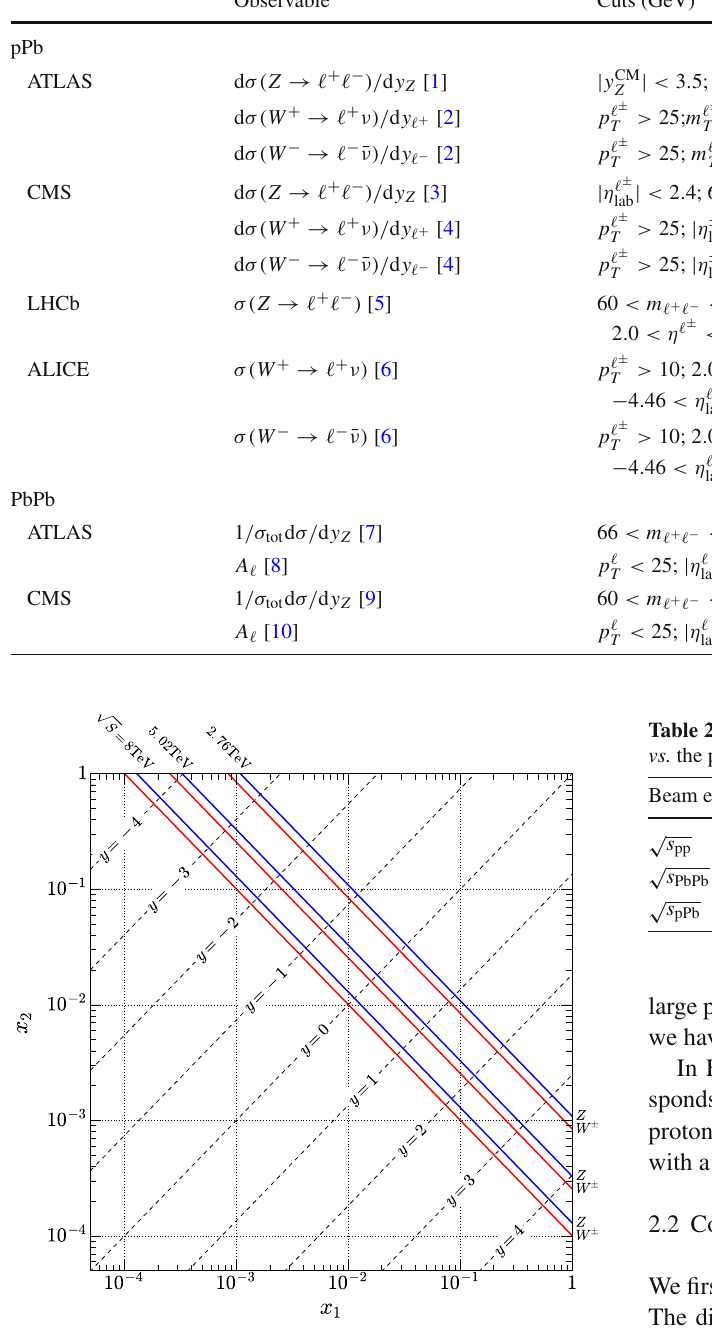
Fig. 1 The kinematic ( x 1 , x 2 ) space explored by the measurements in this study. We display lines of constant τ = M V / the invariant mass of the produced W ± / Z vector boson, as well as the center of mass (CM) rapidity y . In case of pPb collisions, we use the standard convention where x 1 corresponds to the proton and x 2 to the Pb momentum fraction